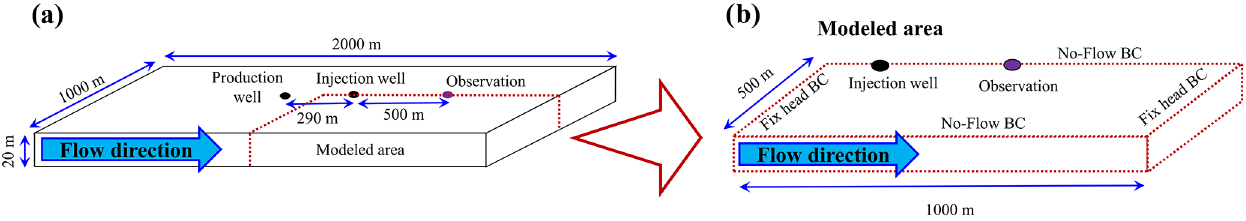
Figure 1. (a) General view of the problem. (b) Detailed view of the modelled area including the boundary conditions (BC).